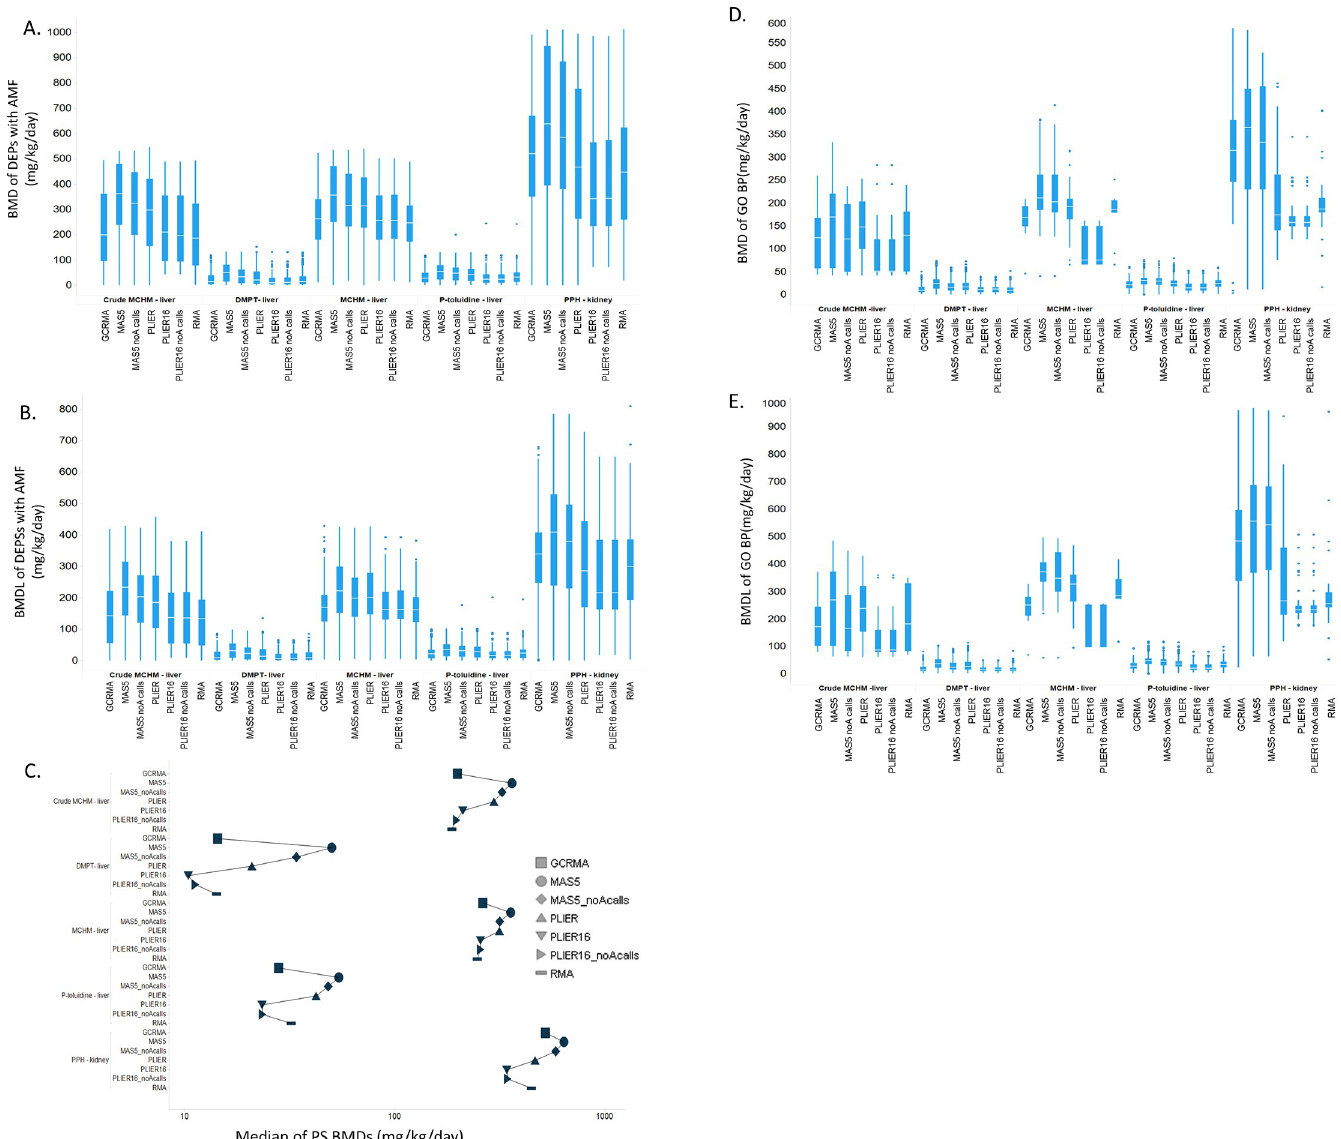
Fig 3. Impact of normalization on the overall distribution of probe set-level BMD (A) and BMDL (B) values and GO:BP median BMD (D) and BMDL (E) values in each of the 5 experiments.